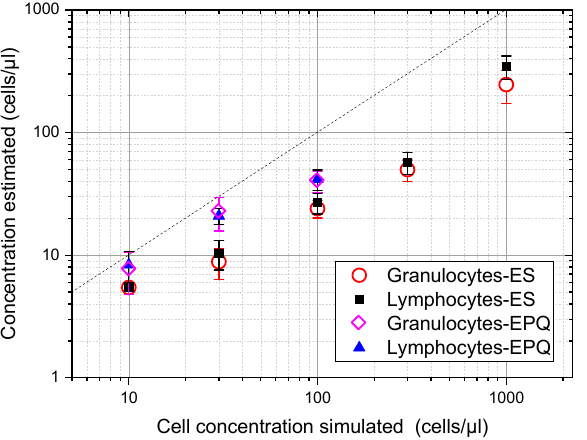
Figure 2. Cell concentration estimation from simulated images of suspensions of lymphocytes and granulocytes using the echo pattern quantification (EPQ) and the envelope statistics (ES) models for single-sized scatterers. The mean sizes and standard deviations of cell suspensions were taken from Table 1. The dash line marks the equivalence between simulated and estimated concentrations.